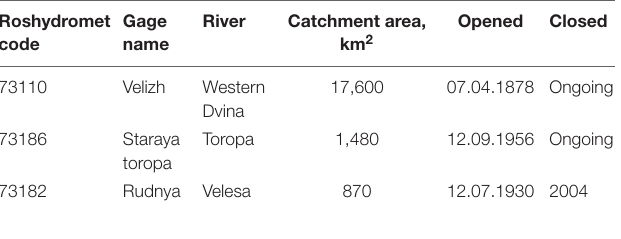
TABLE 1 | Discharge gaging stations situated in the catchment used for model setup, calibration and